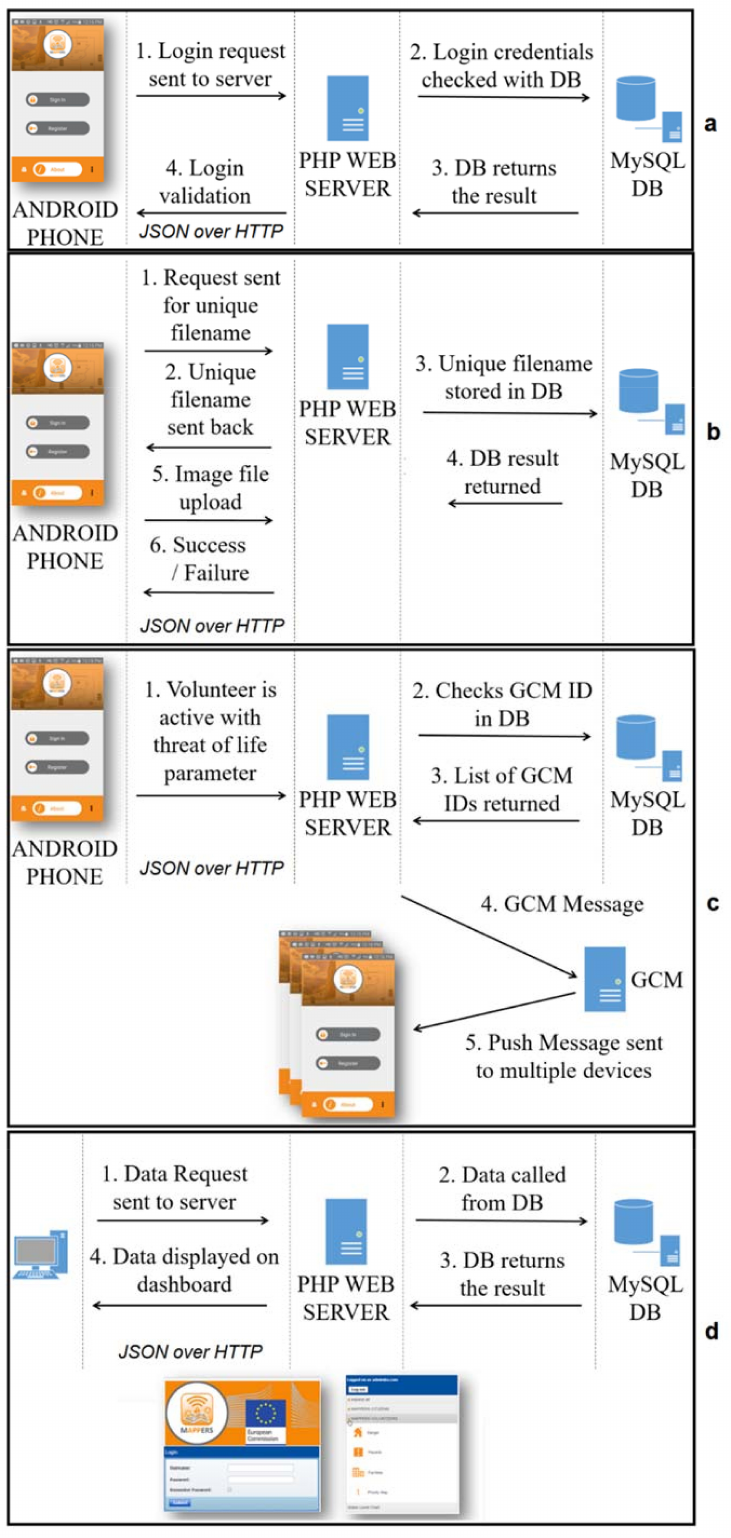
Figure 11. The request-response mechanism for functions of ( a ) Login/Uploading Data, ( b ) Photo Upload, ( c ) Push Notification, and ( d )